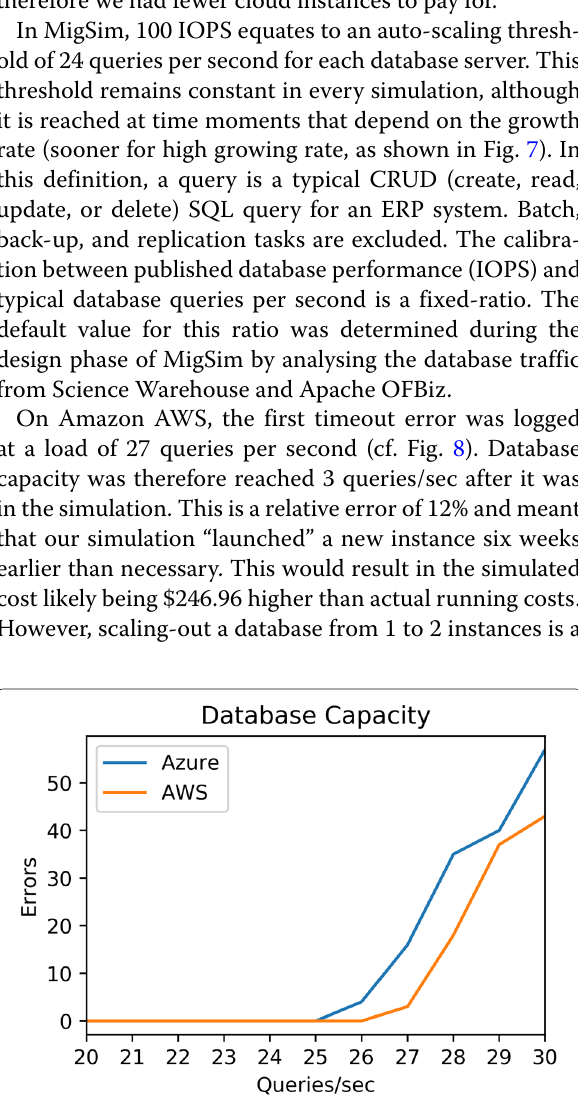
Fig. 8 Timeout errors received at different load